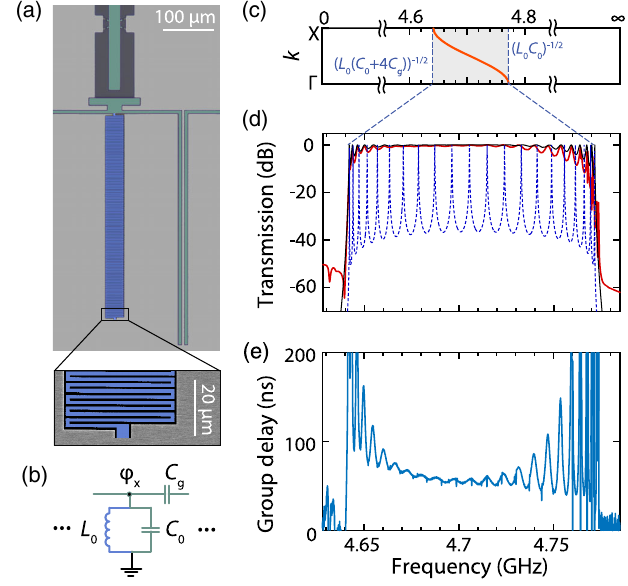
FIG. 1. Microwave coupled resonator array slow-light wave- guide. (a) Optical image of a fabricated microwave resonator unit cell. The capacitive elements of the resonator are false colored in green, while the inductive meander is false colored in blue. The inset shows a false-colored SEM image of the bottom of the meander inductor, where it is shorted to ground. (b) Circuit diagram of the unit cell of the periodic resonator array waveguide. (c) Theoretical dispersion relation of the periodic resonator array. See Appendix B for the derivation. (d) Transmission through a metamaterial slow-light waveguide spanning 26 resonators and connected to 50 - Ω input-output ports. Dashed blue line: theo- retical transmission of finite array without matching to 50 - Ω boundaries. Black line: theoretical transmission of finite array matched to 50 - Ω boundaries through two modified resonators at each boundary. Red line: measured transmission for a fabricated finite resonator array with boundary matching to input-output 50 - Ω coplanar waveguides. The measured ripple in transmission is less than 0.5 dB in the middle of the passband. (e) Measured 5 ns in the group delay τ . Ripples in τ are less than δτ g g g ¼ middle of the